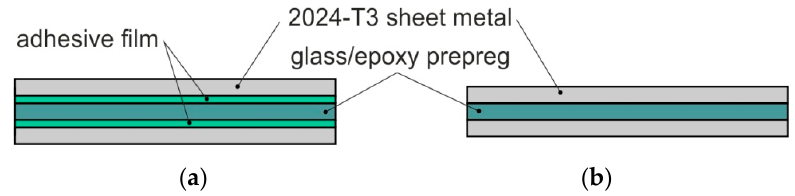
Figure 3. Stacking configurations of the fibre metal laminate (FML) (2 / 1 lay-up) variants